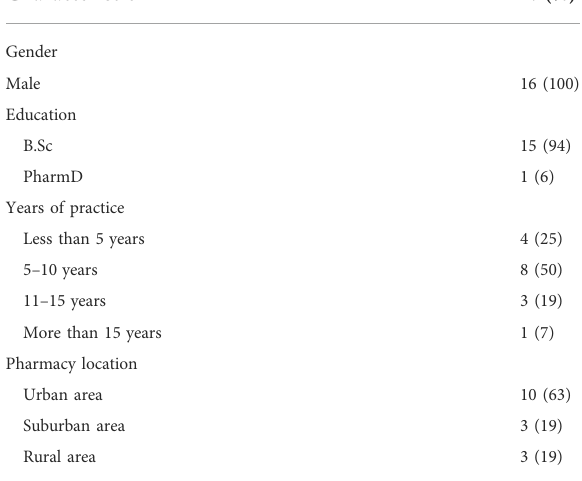
TABLE 1 Demographic details of